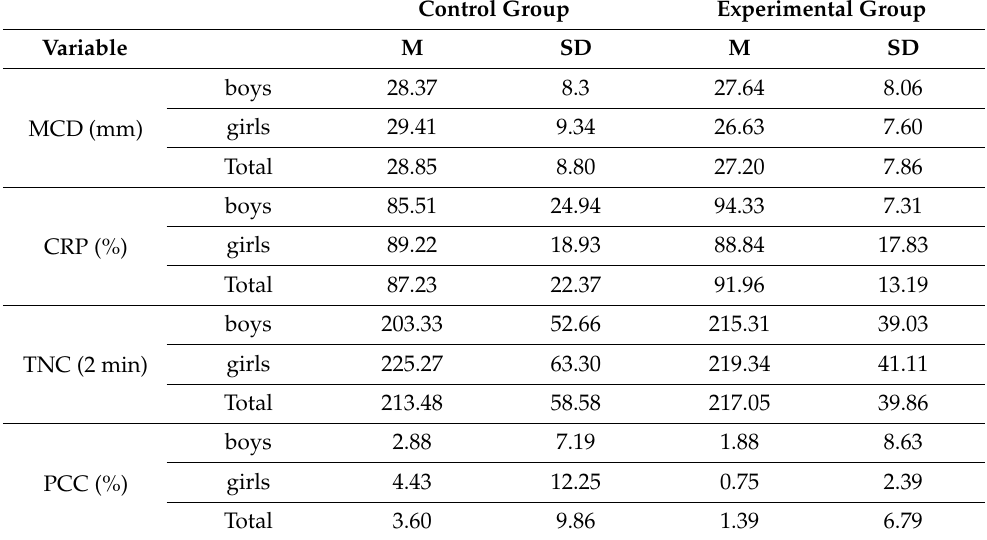
Table 3. Descriptive data of the variables analysed (mean, standard deviation) according to sex and time after training.